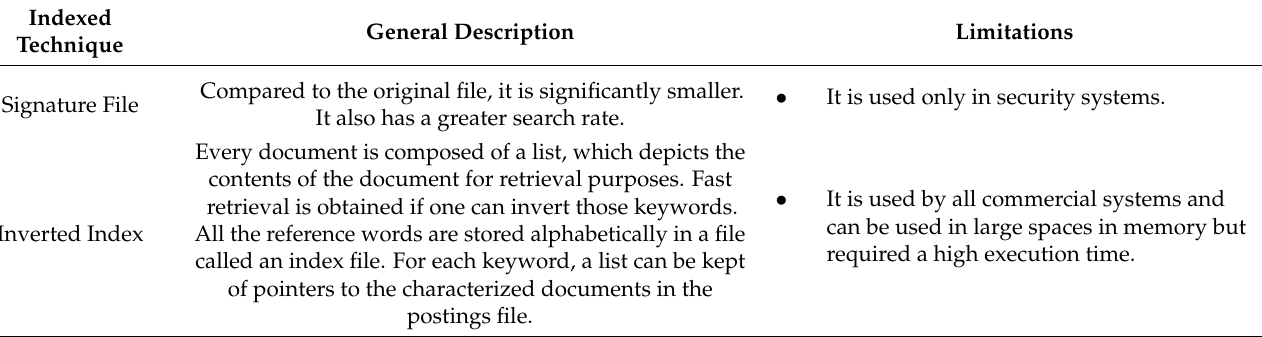
Table 2. General description and limitations of indexed techniques.